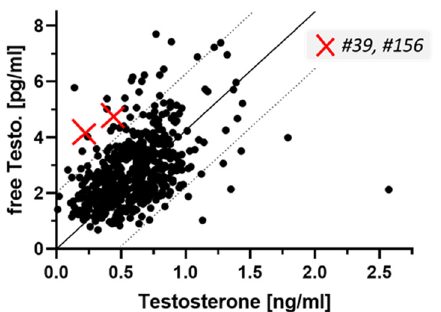
Figure 5. Testosterone and free testosterone concentrations in PCOS patients in relation to LHR- aAb. Two samples were identified as positive for autoantibodies to human LHR (samples #39 and #156, indicated by the red crosses in the xy-plot). In the full cohort of samples, the two steroid parameters show a strong linear correlation (Y = 4.251 × X, p < 0.0001). Testosterone and free testosterone concentrations of the two positive samples positive were outside the 95% and outside the 90% confidence interval, making an incidental finding not very